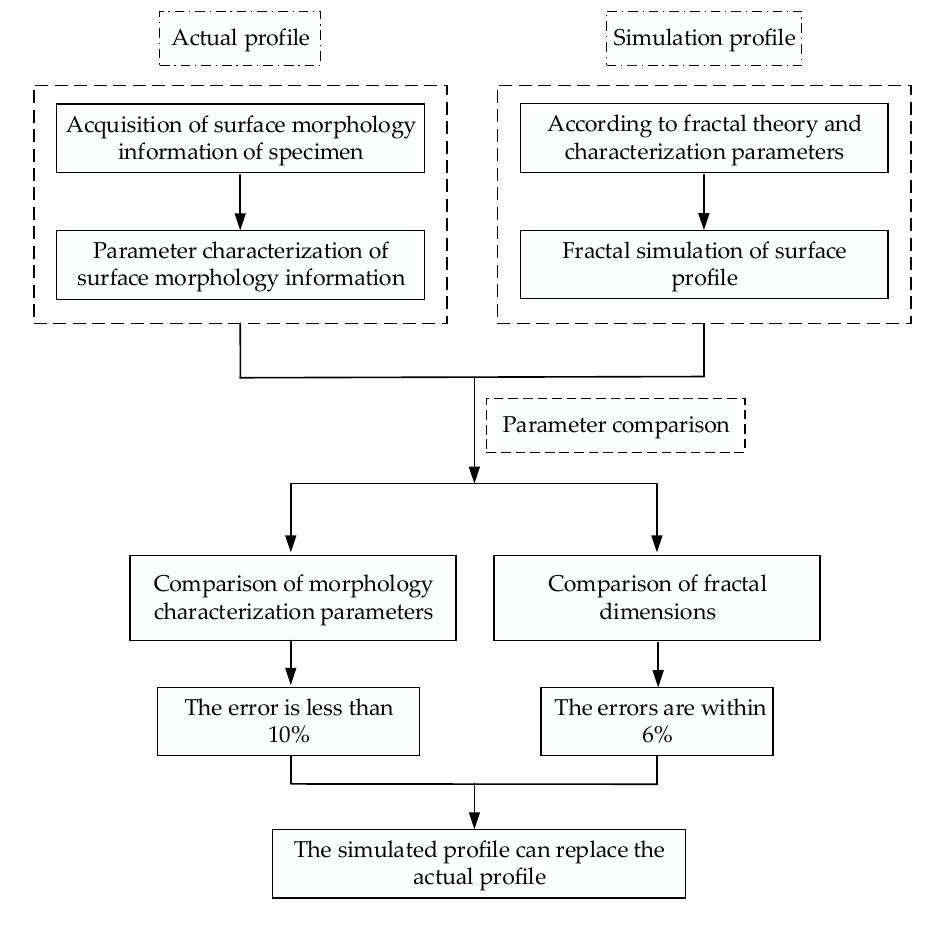
Figure 1. The article block diagram.